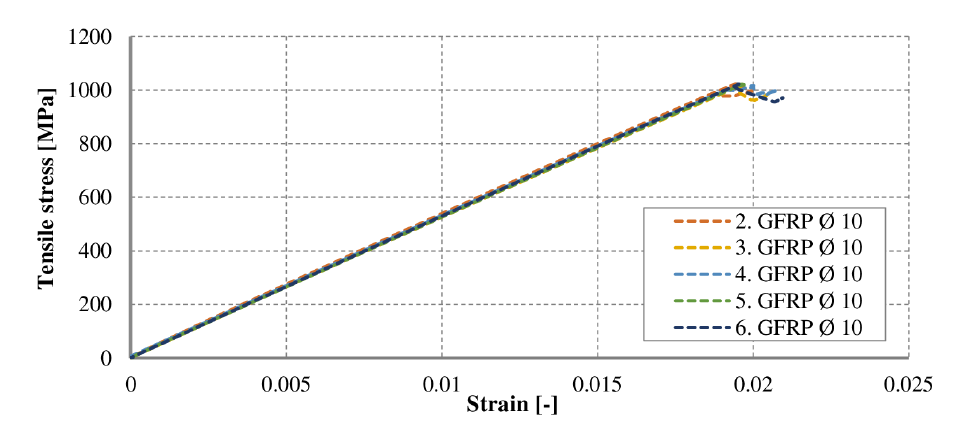
Figure 2. Stress-strain diagram during monotonic tensile test.